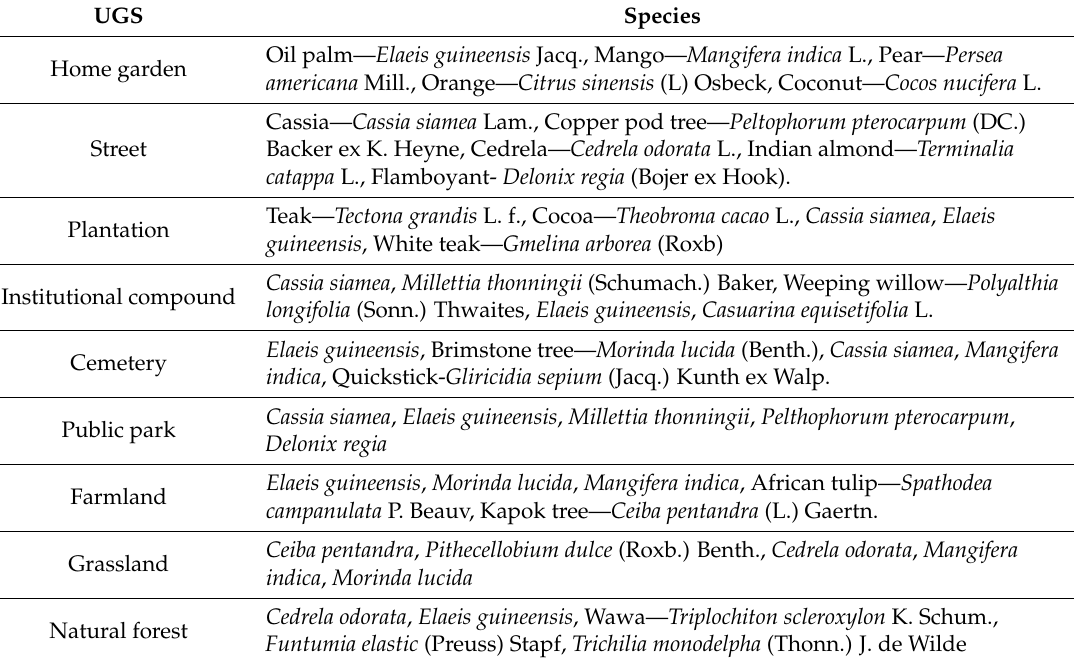
Table 2. Top five most common (abundant) species in each green space type in